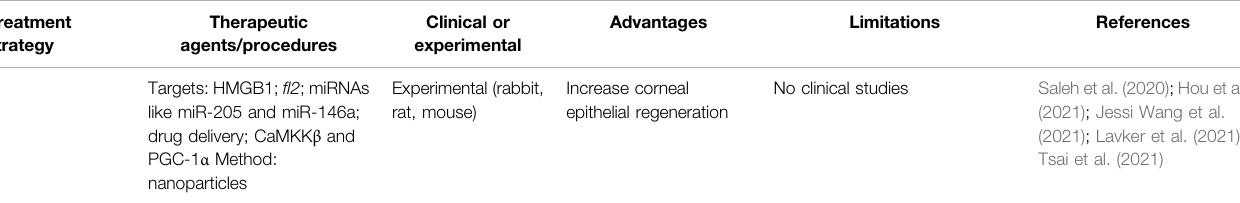
TABLE 1 | ( Continued ) Clinical and experimental therapeutic strategies for anterior segment disorders associated with